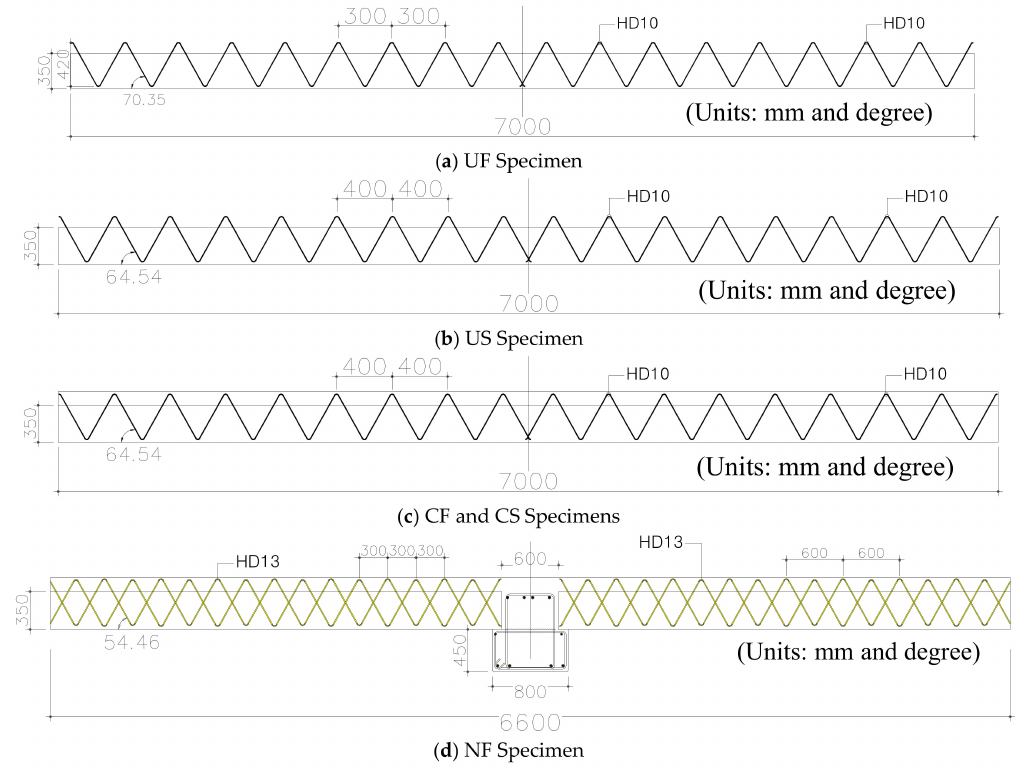
Figure 6. Details of the shear reinforcement (Units: mm and